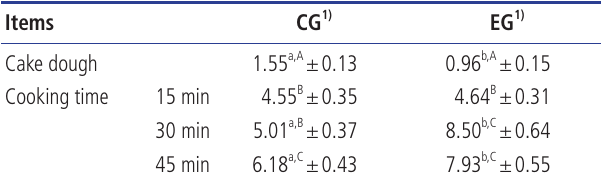
Table 5. Lipid oxidation in cakes baked with different cooking times (15, 30, and 45 minutes) and by using egg yolks from control and experimental group Items